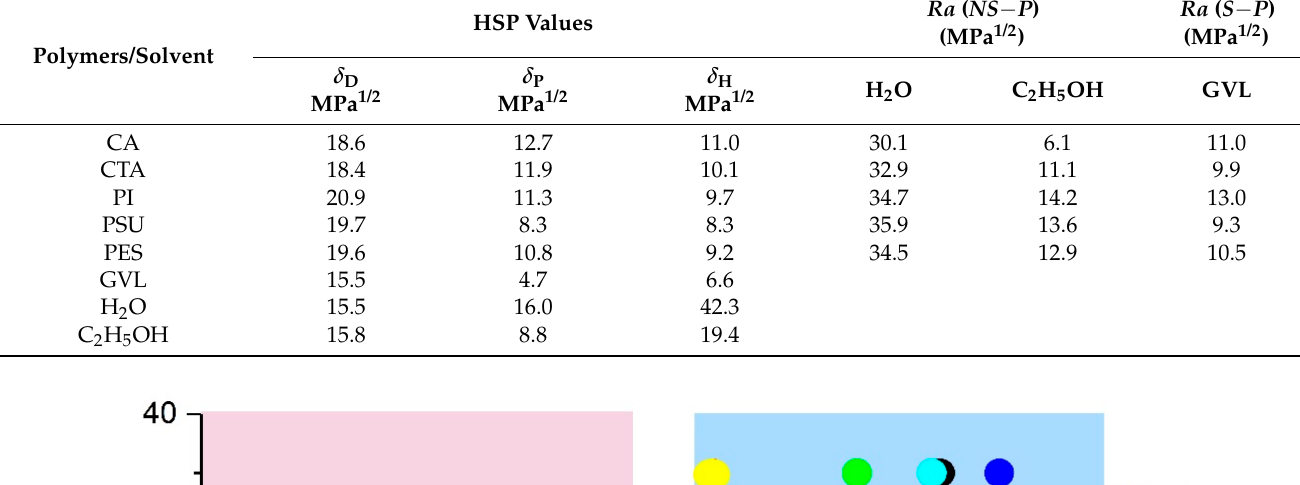
Table 3. Solubility parameters of the polymers, GVL and non-solvents.